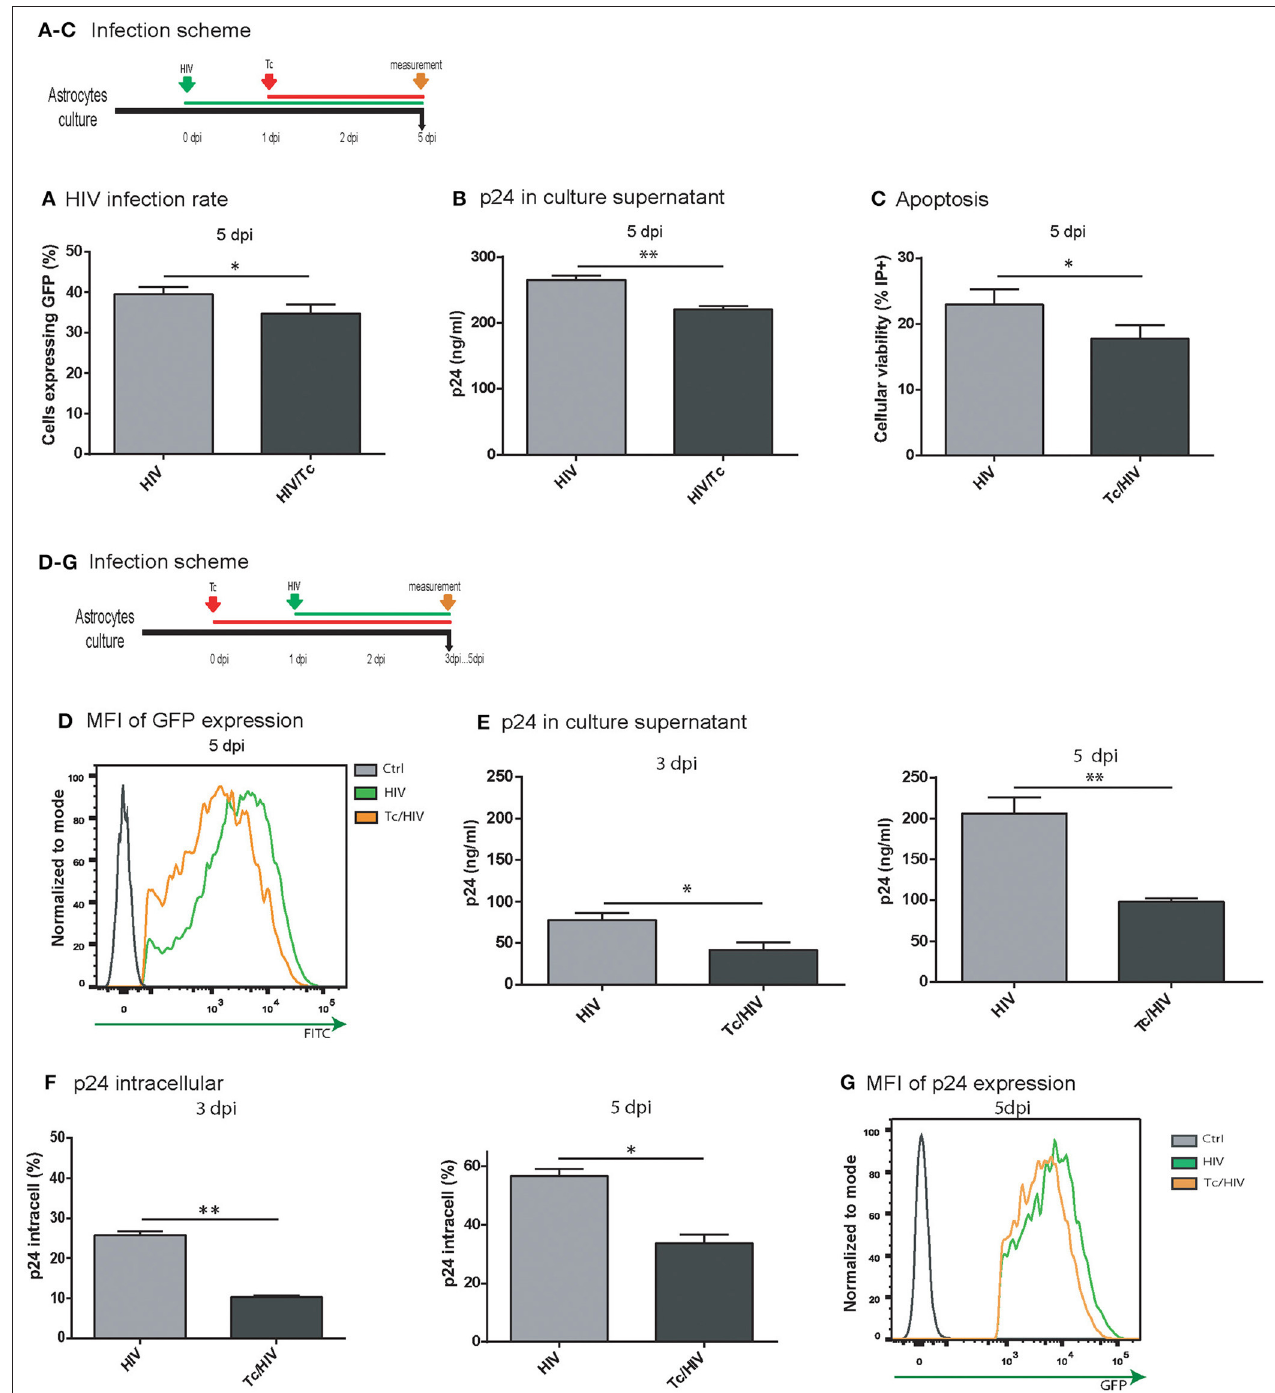
FIGURE 4 | Trypanosoma cruzi impairs HIV-1 replication in astrocytes. Effect of Tc superinfection on HIV replication rate measured by cytofluorimetric analysis as GFP + cells (A) , and by p24 level in culture supernatant expressed in ng/ml) measured by ELISA (B) at 5 dpi. (C) Cell viability measured by flow cytometry as the percentage of propidium iodide positive cells (PI + ) at 5 dpi. (** P < 0.01 and * P < 0.05). (D) Quantitative analysis of HIV-GFP positive cells proportion and mean fluorescence intensity (MFI) measured by flow cytometry at 5 dpi. (E) Tc impact on HIV replication rate measured as p24 level (in culture supernatant expressed in ng/ml) at 3 and 5 dpi. (F) Tc impact on HIV replication rate measured by flow cytometry analysis of intracellular p24-FITC expression at 3 and 5 dpi (** P < 0.01 and * P < 0.05). (G) Quantitative analysis of p24-FITC + cells and mean fluorescence intensity (MFI) measured by flow cytometry at 5 dpi.